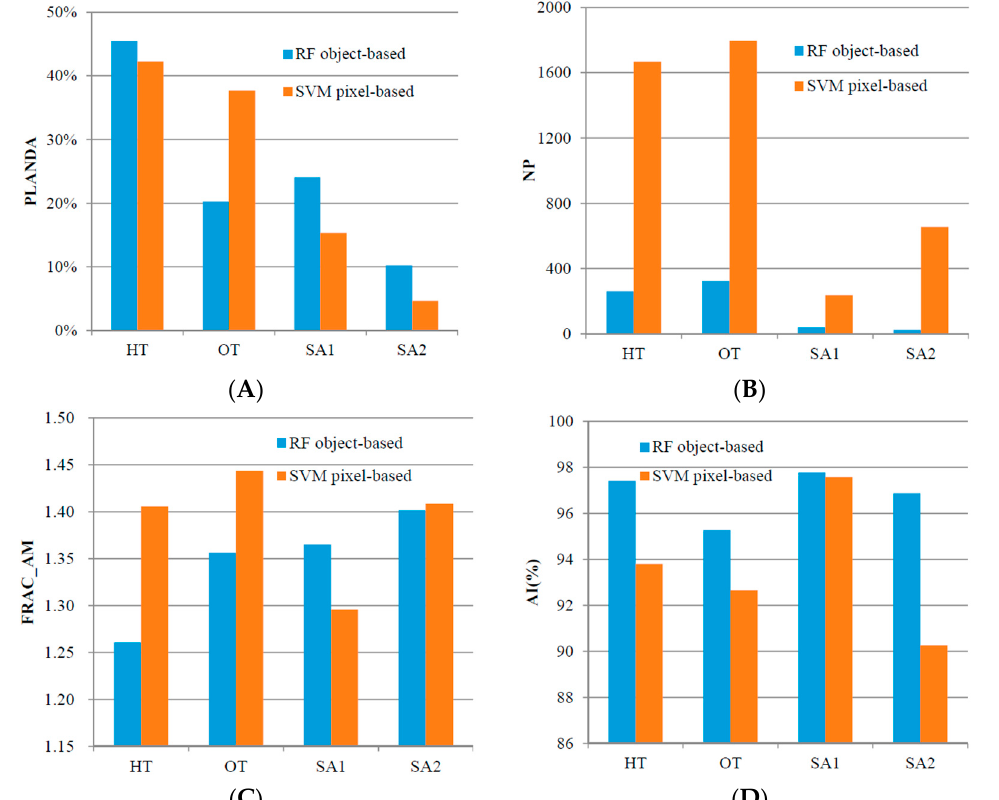
Figure 6. The comparison of landscape pattern metrics of RF object-based and SVM pixel-based classification at class level: ( A ) PLAND represents the percentage of landscape; ( B ) NP represents the number of patches; ( C ) FRAC_AM represents the area-weighted mean patch fractal dimension; and ( D ) AI represents the aggregation of patches.